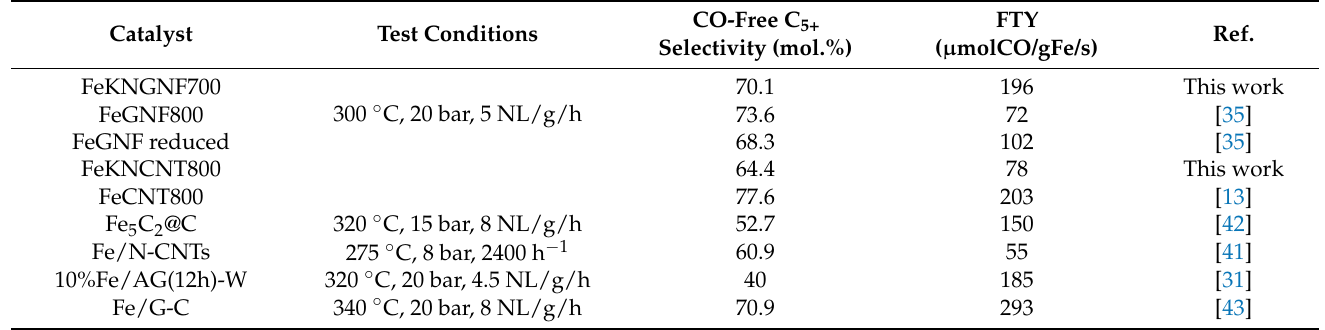
Table 3. Performances of FeKNGNF700 and FeKNCNT800 catalysts in FTS compared with the literature data for unpromoted carbon supported Fe-based